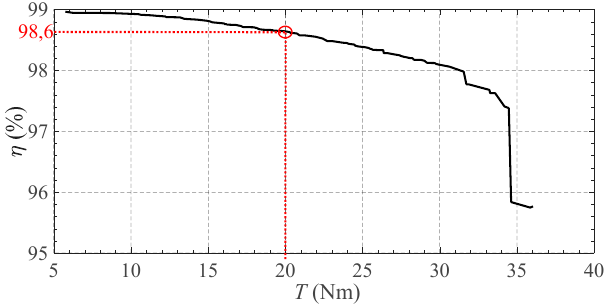
Figure 11. Pareto front—Objective functions.